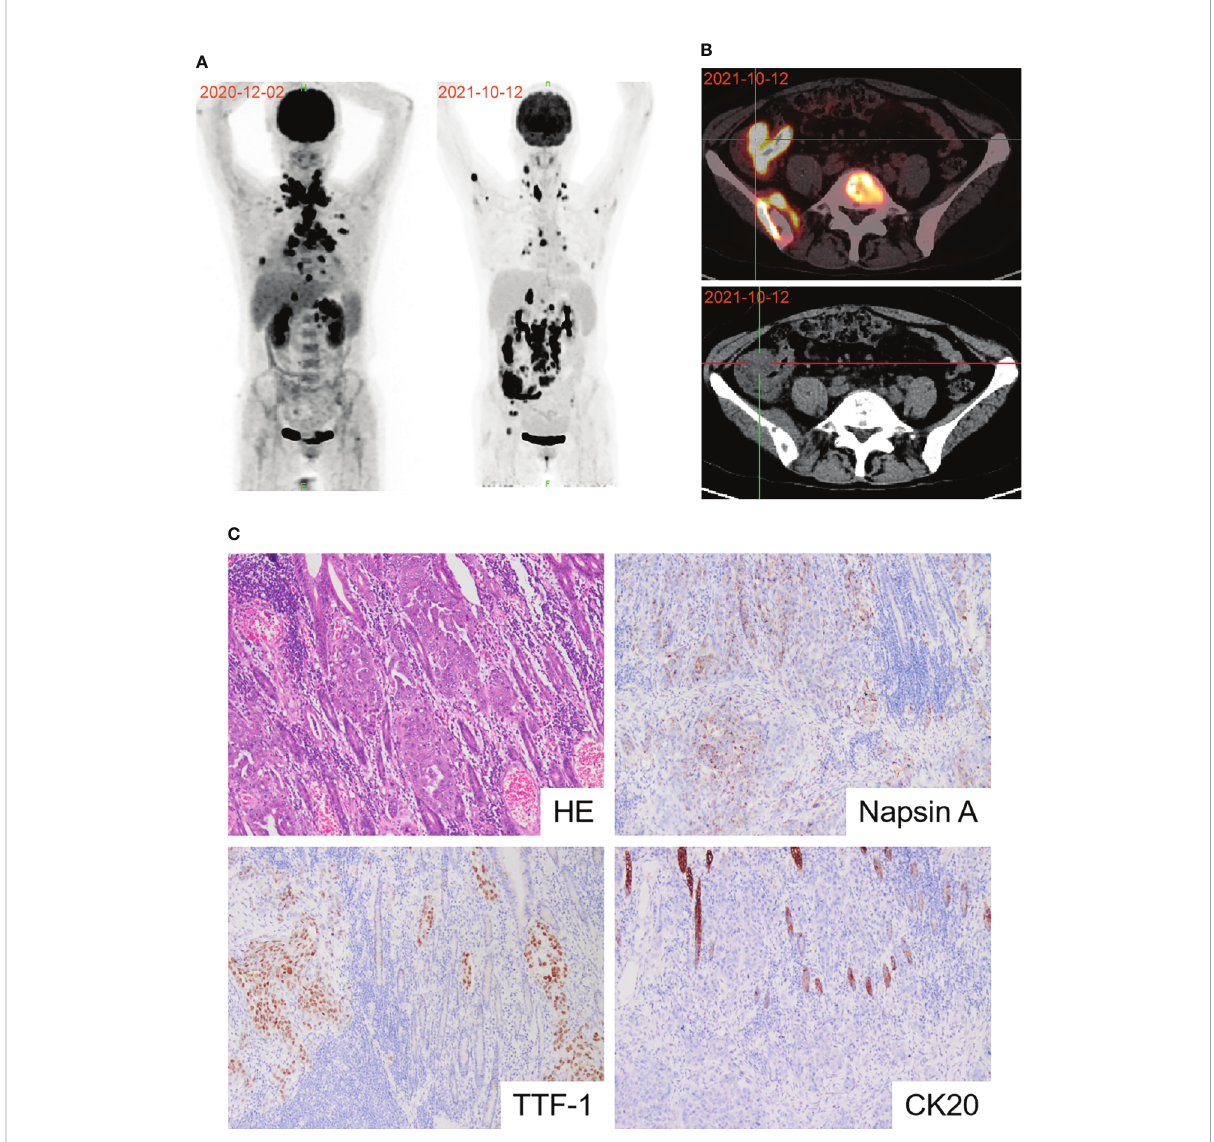
FIGURE 2 Diagnosis of colon metastasis from lung adenocarcinoma. (A) PET-CT scan showed the effects of fi rst-line immunochemotherapy. (B) Representative PET-CT image of colon metastasis. (C) Pathological image of postoperative colon mass notarized colon metastasis of lung